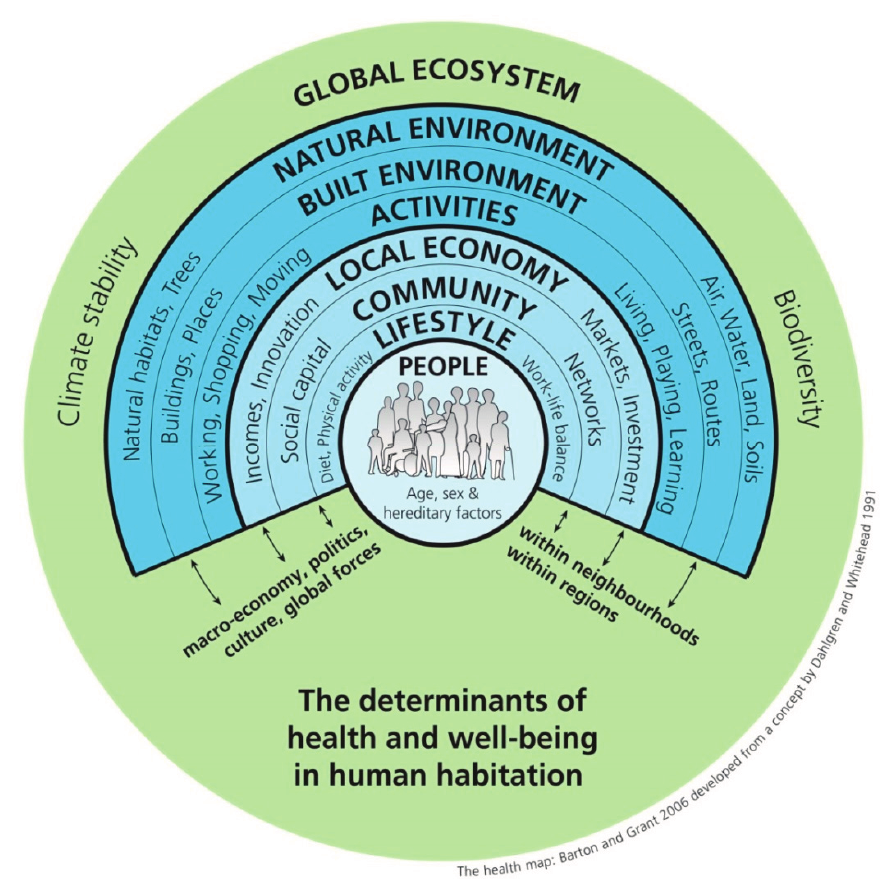
Figure 1. An Ecological Model of